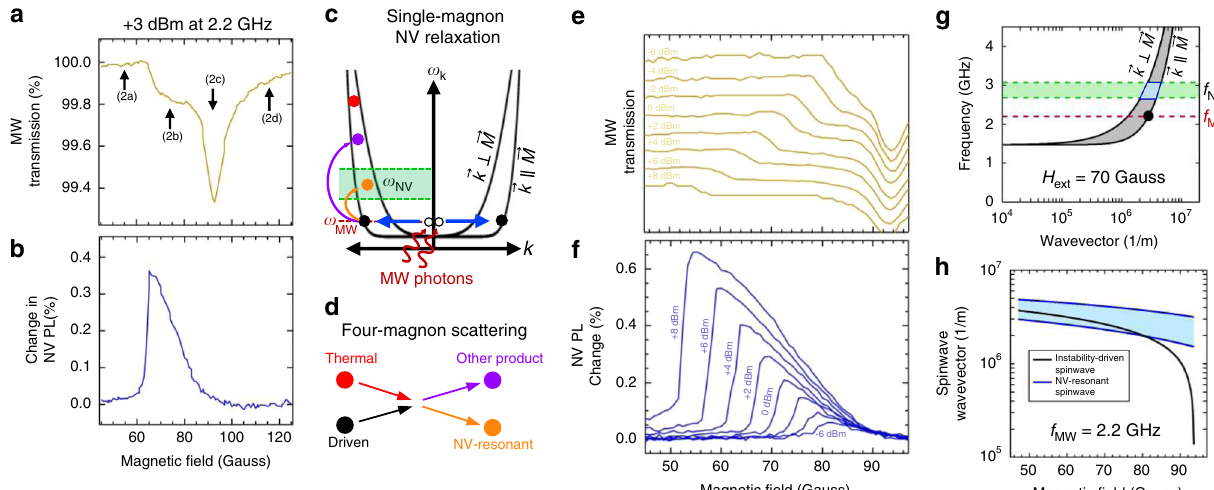
Fig. 3 NV detection of spinwave instability in the single-magnon NV relaxation regime. a Microwave absorption during a static magnetic fi eld sweep at 2.2 GHz and + 3 dBm microwave power shows a uniform mode FMR absorption signal at 94 Gauss and an absorption shoulder at lower magnetic fi eld, consistent with the model in Fig. 2. b Simultaneously collected NV relaxation is strongest at the lowest fi eld where the instability is driven and is minimal at the uniform mode FMR condition. c Out-of-equilibrium magnons driven by the instability (black) scatter off thermally occupied magnons (red), resulting in product magnons, some of which may be NV-resonant (yellow). An increase in population of NV-resonant magnons increases the dipole fi eld noise at NV frequencies, leading to a change in NV PL. d The four-magnon scattering process redistributes excess magnon population from the driven mode to higher frequencies. e Increasing microwave power shifts the instability shoulder detected by microwave absorption toward lower magnetic fi eld. Curves are vertically shifted from one another for readability. f NV relaxation signal follows the instability shoulder, shifting toward lower magnetic fi eld with increasing microwave power. g Calculated spinwave manifold (gray) and NV center frequency range (green) at 70 Gauss gives the wavevector of